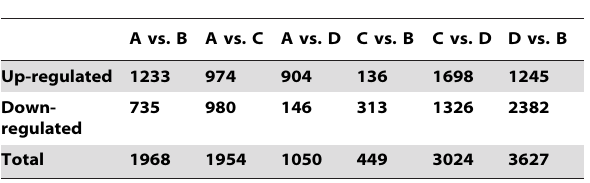
Table 1. Differential expression of lncRNAs in